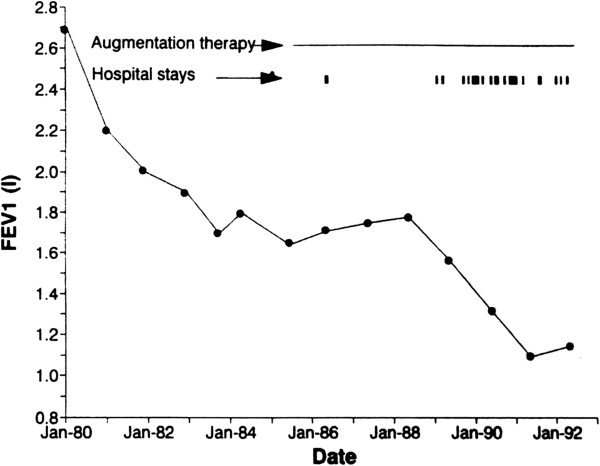
The decline in FEV1 (l) for a 41 year-old male. Footnote: Between 1980 and 1985 a severe drop in FEV1 from 2.7 to 1.7 liters was noted. Started with augmentation therapy in 1985, the lung function parameters stabilised over a period of approximately 3 years. The number of severe pulmonary infections requiring hospitalisation increased from 1989 and were accompanied by a rapid decrease in FEV1. Published from reference 46 with permission from S. Karger AG Basel.